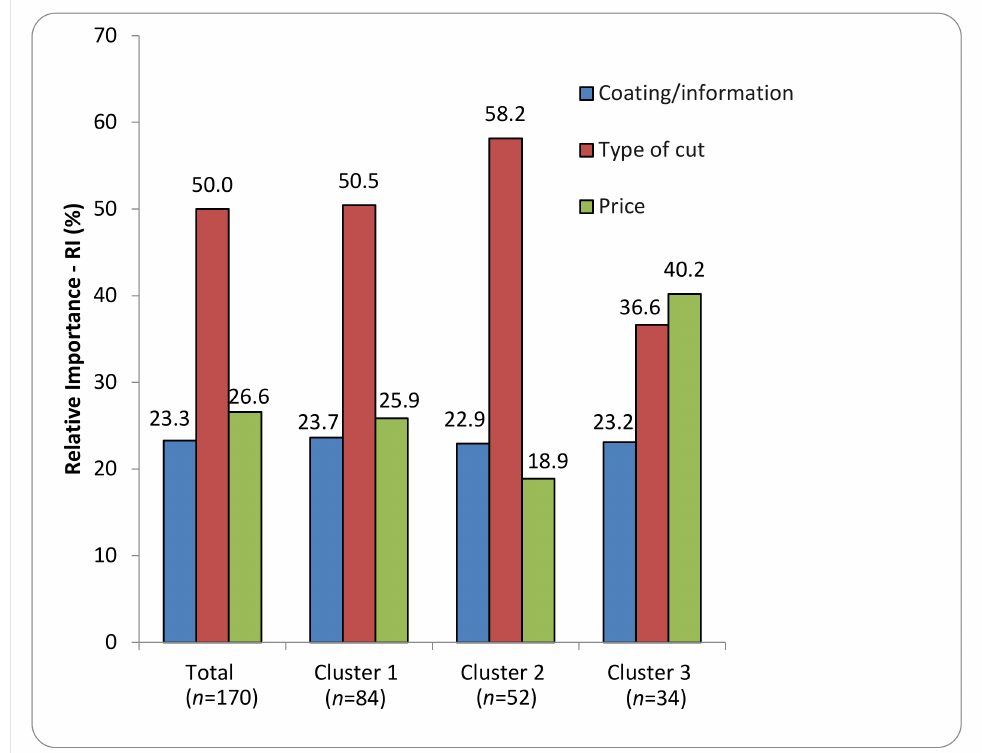
Figure 2. Relative importance (RI) of different factors for total consumers and clusters.